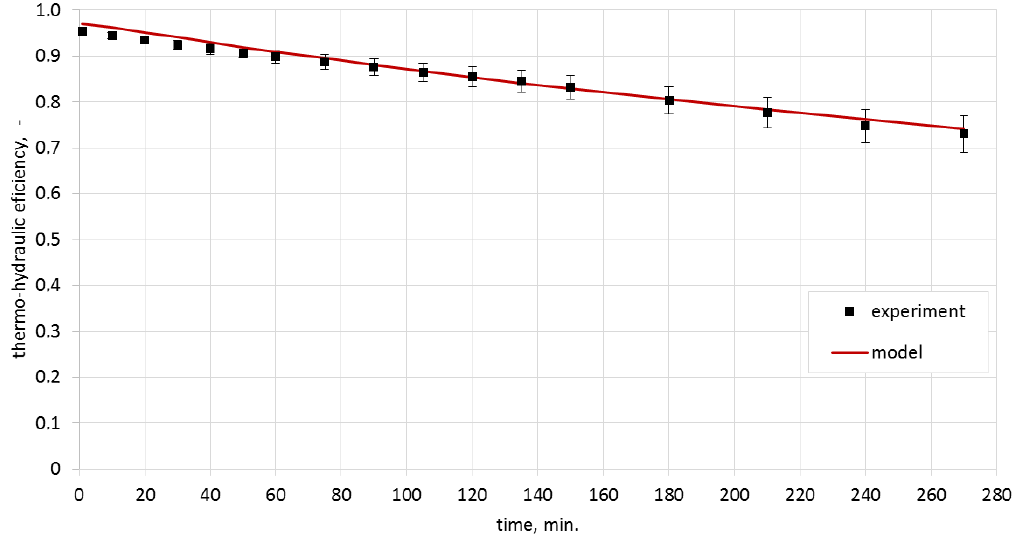
Figure 9. Thermo-hydraulic efficiency for the airflow rate of 0.0068 m 3 /s.